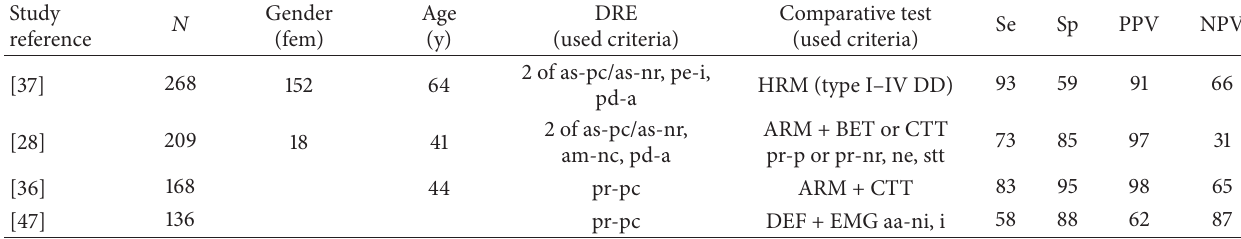
Table 3: Summary of studies with digital rectal